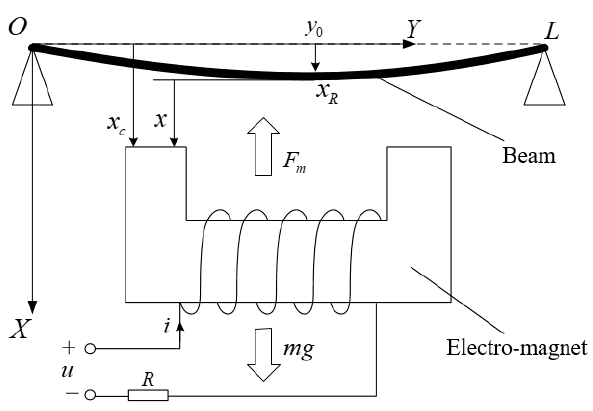
Figure 2. Single-point suspension system considering elastic beam.